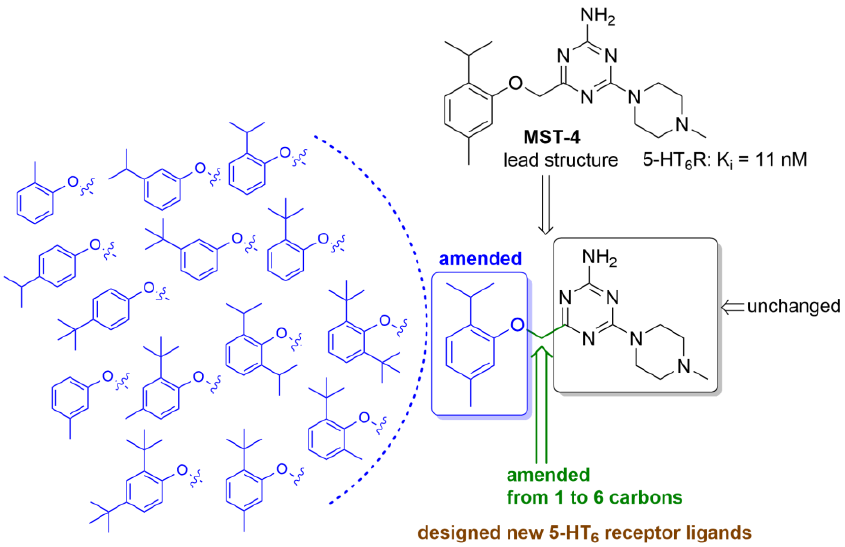
Figure 2. Design of novel compounds based on promising lead compound MST4.